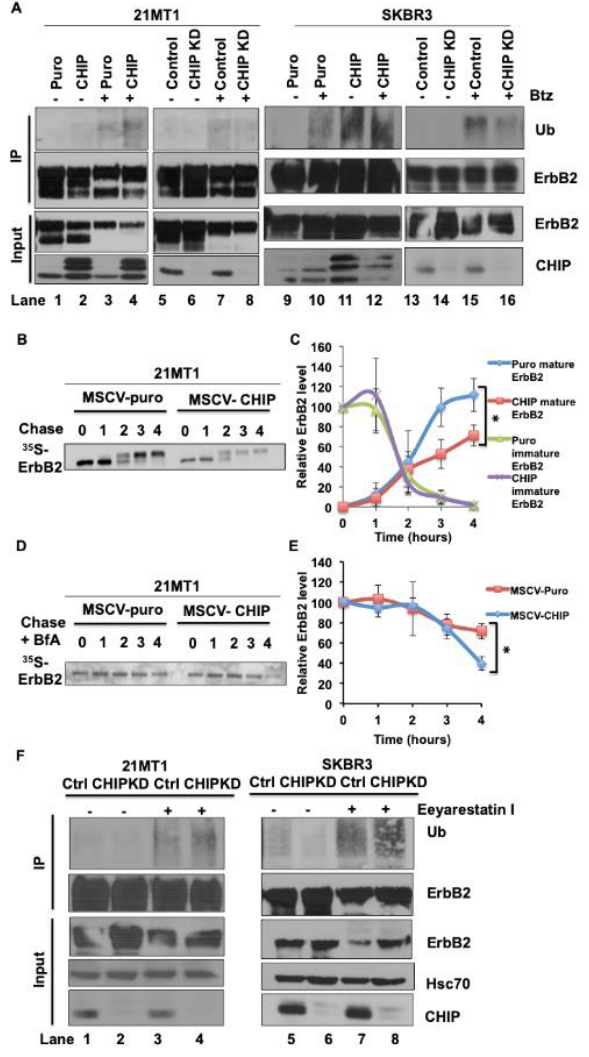
Figure 2. CHIP elevates the basal ubiquitination of ErbB2 during its maturation. ( A ) 21MT1 and SKBR3 cells were seeded in 10 cm dishes and incubated with or without proteasome inhibitor Bortezomib (1 µ M) for 4 h. Cleared lysates (1 mg protein) of the indicated cells were subjected to ErbB2 immunoprecipitation using Trastuzumab (5 µ g/mL). Ubiquitinated ErbB2 signals were detected by anti-ubiquitin immunoblotting (upper panel). ErbB2 and CHIP levels in whole cell lysates are shown in the lower panel. ( B ) 21MT1 cells were pulse-labeled for 20 min with [ 35 S]-methionine/cysteine and were then chased with excess (100-fold) unlabeled methionine/cysteine-containing medium. Cleared lysates from cells harvested at the indicated time points were used for immunoprecipitation with anti- ErbB2 antibody (Trastuzumab), and immunoprecipitates were resolved by SDS-PAGE and visualized by autoradiography. ( C ) Relative ErbB2 level quantification in B. Data represent mean ± SEM, n = 3, * p < 0.05. ( D ) 21MT1 cells were pulse-labeled for 20 min with [ 35 S] methionine-cysteine and chased with excess unlabeled methionine-cysteine medium in the presence of Brefeldin A (1 µ g/mL). Cleared lysates from cells harvested at the indicated time points were immunoprecipitated with anti-ErbB2 antibodies, followed by autoradiography. ( E ) Relative ErbB2 level quantification in ( C ). Data represent mean ± SEM, n = 3, * p < 0.05. ( F ) 21MT1 or SKBR3 cells were seeded in 10-cm dishes and incubated with or without Eeyarestatin I (1 µ M) for 4 h. Cleared lysates (1 mg protein) of the indicated cells were subjected to ErbB2 immunoprecipitation using Trastuzumab (5 µ g in 1 mL). Ubiquitinated ErbB2 signals were detected by anti-ubiquitin immunoblotting (upper panel). ErbB2 and CHIP levels in whole cell lysates are shown in the lower